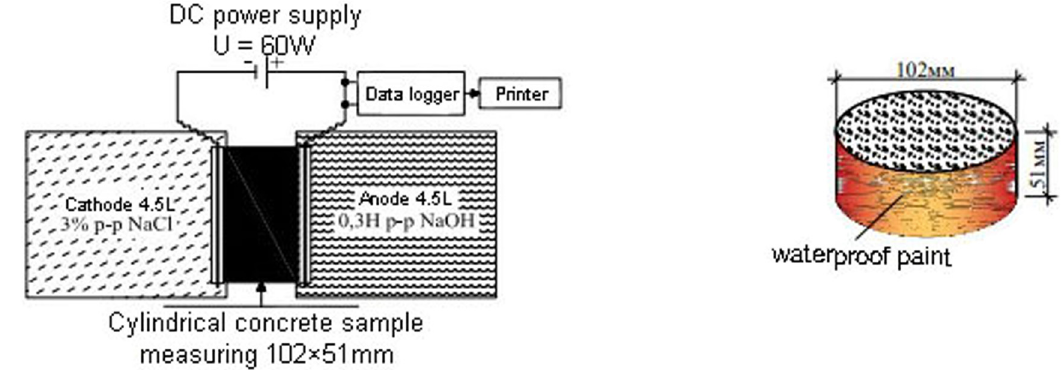
Figure 3: Experimental setup for determining the permeability of a concrete specimen to chlorine